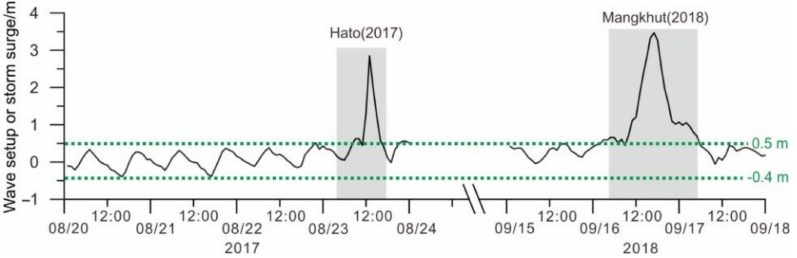
Figure 10. Time-series variation of wave setup or storm surge along ML beach during Typhoon Hato (2017) and Mangkhut (2018). Grey bands highlight the period in which storms induced significant